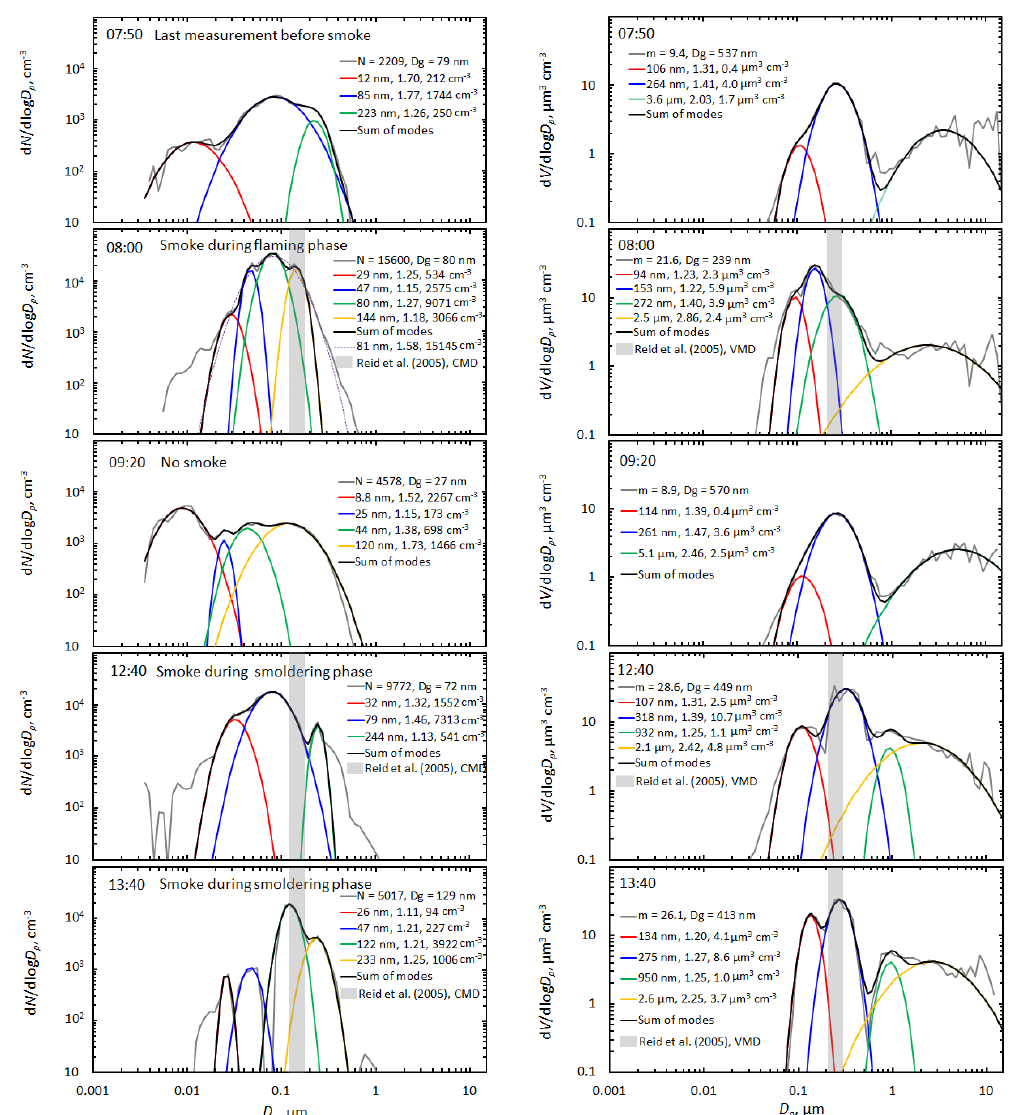
Fig. 10. Selected particle size distributions measured with DMPS and APS in the aerosol cottage. The left column: number size distributions; right column: volume size distributions. In each plot, the grey line represents the measured size distribution and the associated numbers: the number concentration in cm − 3 (left column), the mass concentration integrated to 10µm inµgm − 3 calculated assuming a density of 1.5gcm − 3 (right column), and the geometric mean diameter ( D g ) of the whole size distribution. The modal parameters are the geometric mean diameter, the geometric standard deviation, and the number or volume concentration of the mode. The grey shaded band in the smoke size distributions shows the range of count median diameters (CMD) and volume median diameters (VMD) of smoke aerosol from temperate- forest prescribed fires and wildfires in the review by Reid et al.